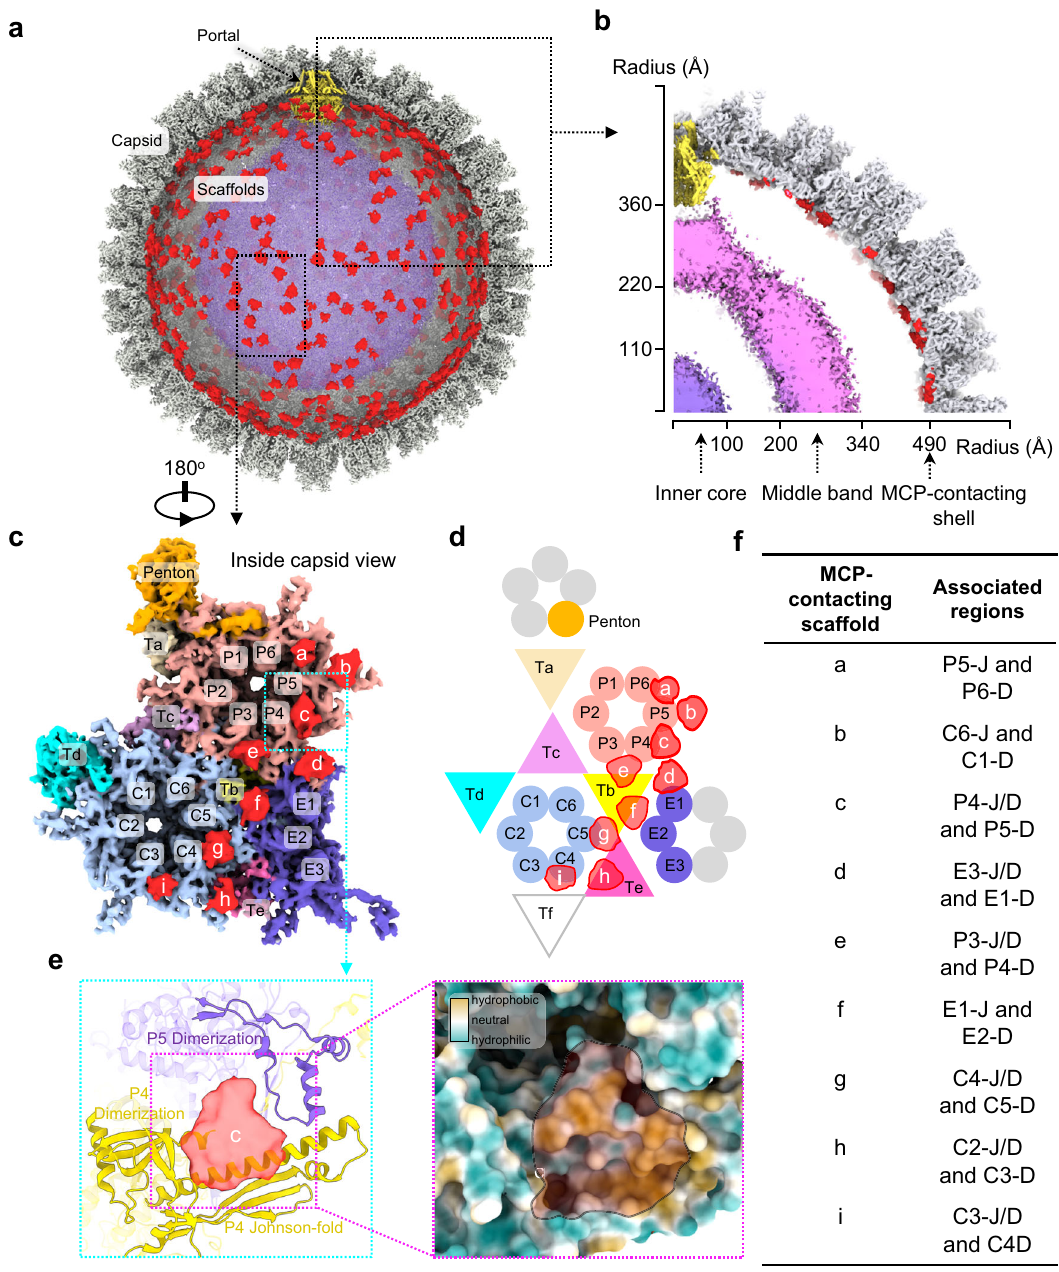
Fig.2|InteractionsbetweenscaffoldsandMCPs.a Asymmetricreconstructionof theHCMVB-capsidwiththefronthalfofthecapsidshell(gray)removed.Theportal isinyellowandthethreelayersofscaffoldsarecoloredasinFig.1a. b Cross-section of one-quarter of the B-capsid map, showing the radial distribution of the three layersofthescaffolds.Densitymap( c )andschematic( d )ofoneasymmetricunitof the icosahedral B-capsid, showing scaffold densities contacting with the capsid shell. The MCPs in center- (C-hexon), peripenton- (P-hexon), edge-hexons (E-